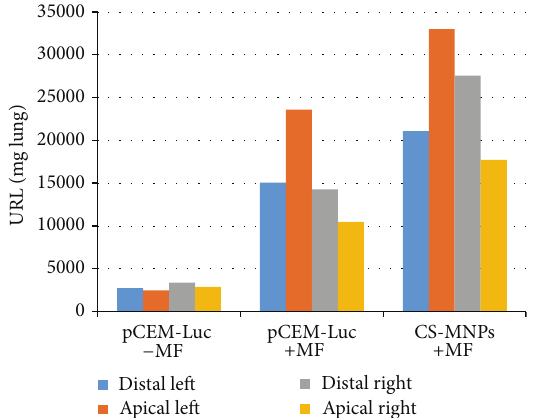
Figure 6: Determination of luciferase activity in vivo . Expression of luciferase in different regions of lungs (distal-L, apical-L, distal- R, and apical-R) transfected with naked plasmid unexposed to a magnetic field (pCEM − MF) and exposed to a magnetic field (pCEM+MF) or magnetic nanoparticles exposed to a magnetic field